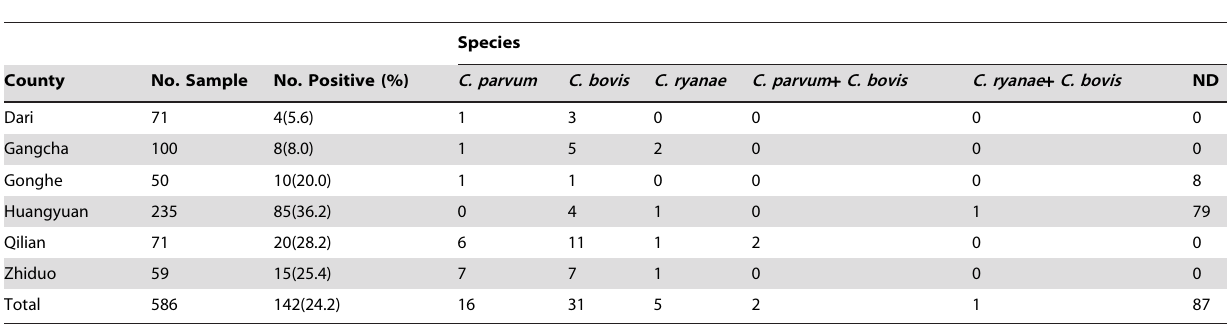
Table 1. Prevalence and molecular characterization of Cryptosporidium spp. in different counties.